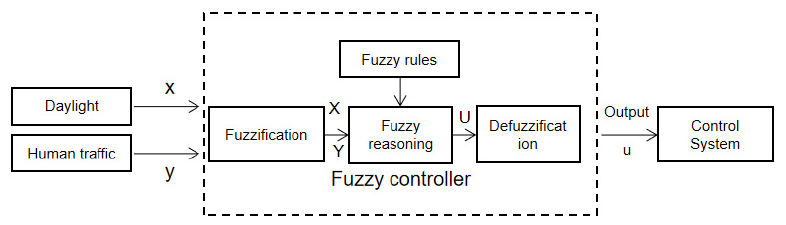
Figure 3. Fuzzy control model diagram.